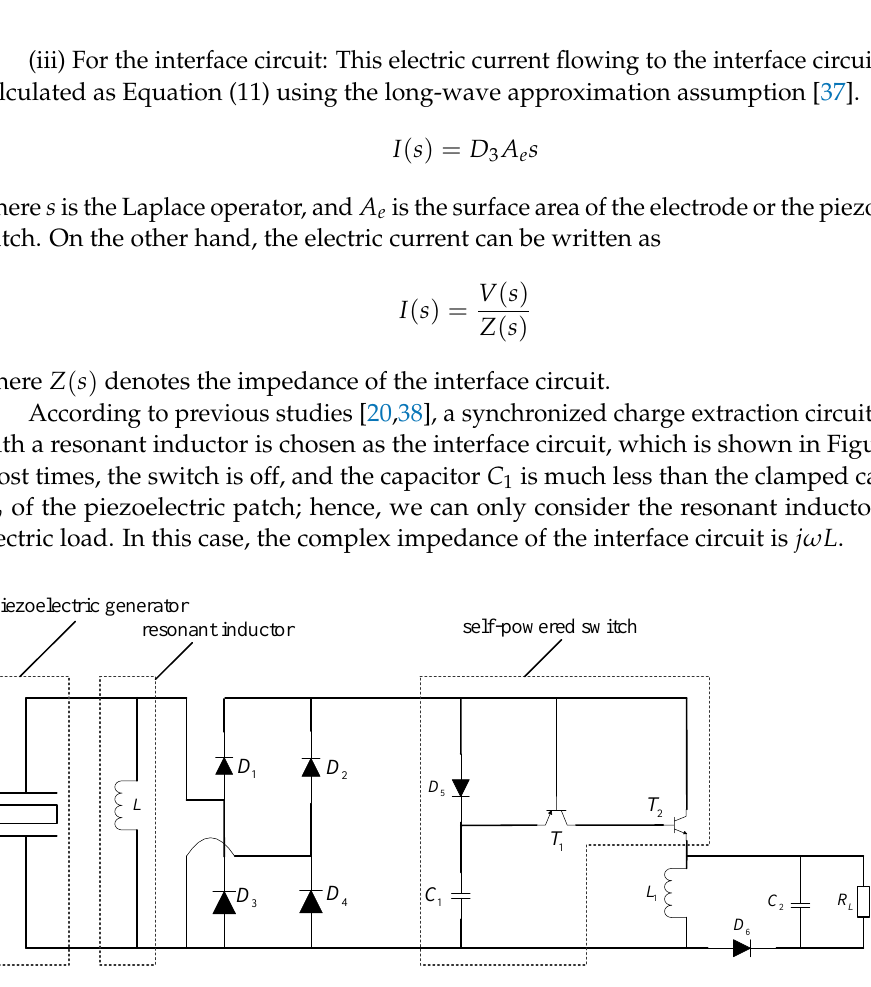
Figure 3. The structure of a self-powered SCEC with a resonant inductor. By combing Equations (11) and (12), the following formulation can be obtained in the complex-frequency domain.